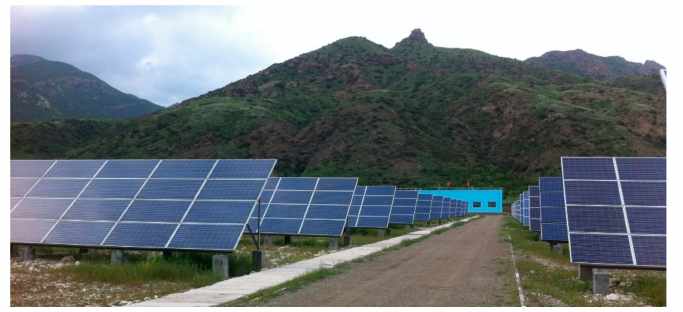
Figure 6. The grid-connected photovoltaic (PV) farm used in the case study in this